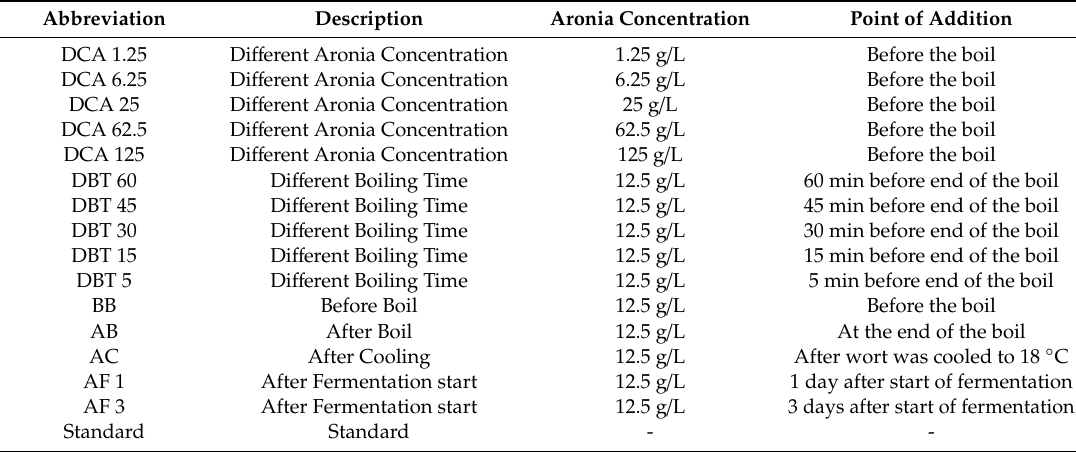
Figure 1. Flowchart of brewing process . Table 1. Sample coding and infusion conditions .